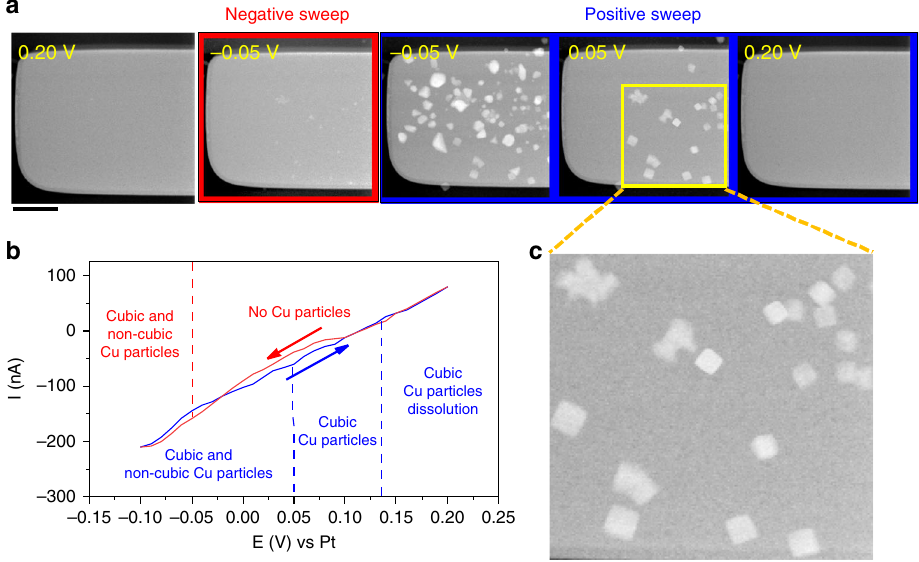
Fig. 1 Electrochemical deposition of Cu 2 O cubes. a STEM images of the Pt working electrode at different potentials. The scale bar corresponds to 2 µ m. b Cyclic voltammetry recorded at a scan rate of 5 mVs − 1 in 5 mM CuSO 4 + 5 mM KCl solution. c Expanded image extracted from the STEM image of the working electrode at − 0.05 V during the positive-going scan clearly identifying Cu 2 O cubes on the electrode. The scale bar corresponds to 500